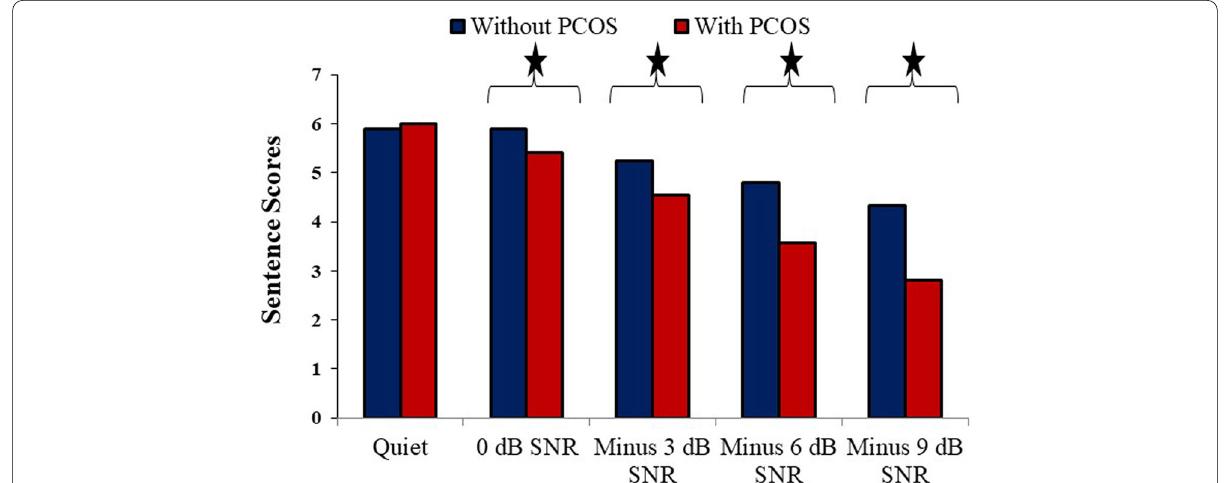
Fig. 3 Mean and Standard deviation of the SPIN scores for sentences obtained from women with and without PCOS. Asterisk indicates the significant pairs